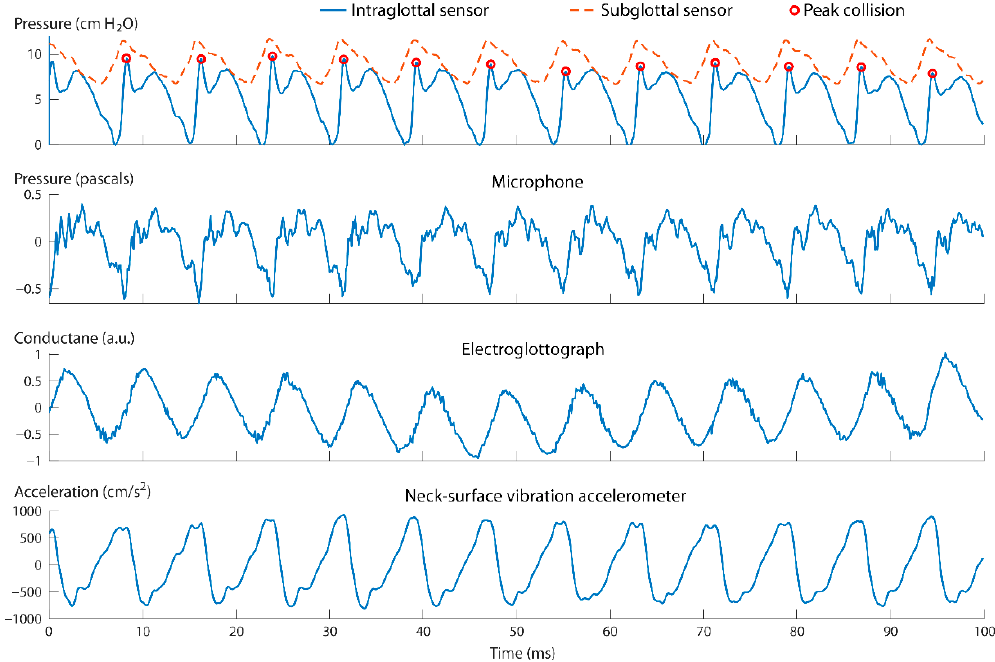
Figure 4. Calibrated signals recorded during a phonatory segment when the intraglottal pressure sensor was determined to be in the strike zone. Shown as circles are the peak collision pressures in the intraglottal sensor signal during each phonatory cycle.